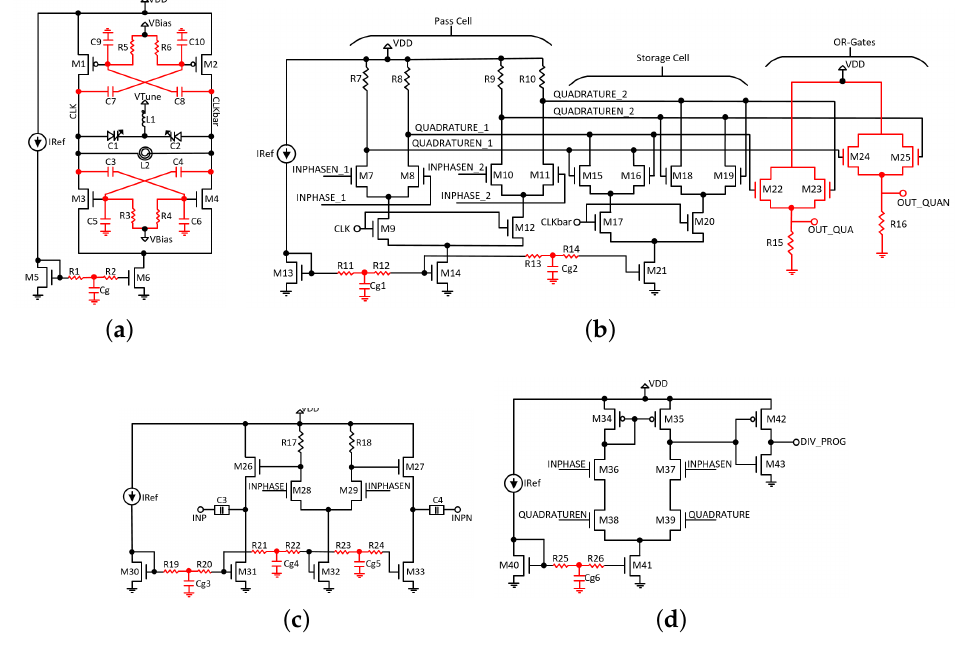
Figure 8. Radiation hardening-by-design (RHBD) schematics. ( a ) VCO; ( b ) Slave stage of the FD2; ( c ) MB; ( d ) CML2CMOS converter.